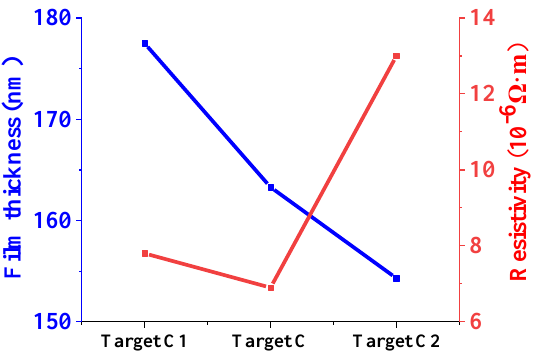
Figure 10. Thickness and resistivity of three kinds of films.